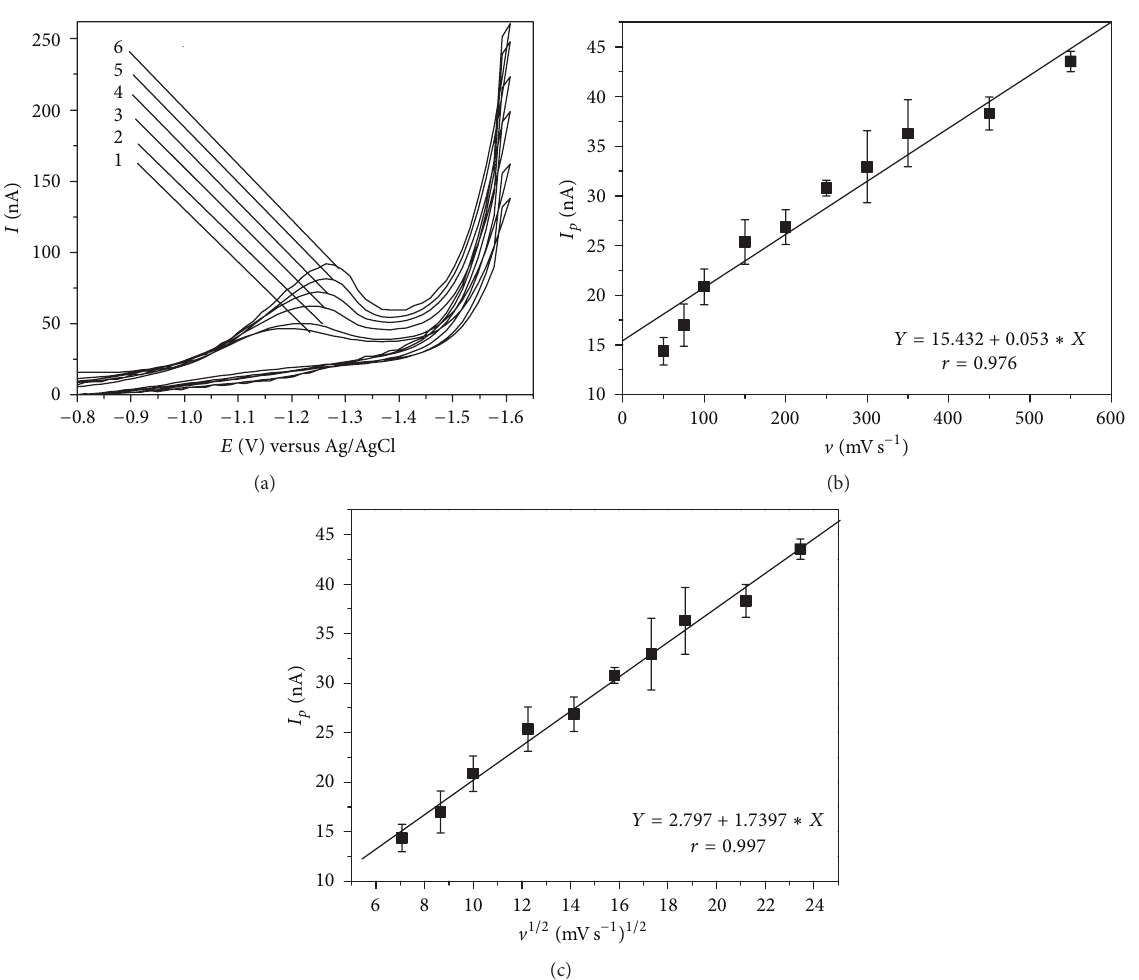
Figure 2: Study of the electrochemical process of EE2 (119.5 𝜇 gL −1 ) in Britton-Robinson buffer (pH 7.0) at HMDE by cyclic voltammetry. (a) Cyclic voltammograms with scan rates: (1) 50 mVs −1 ; (2) 100 mVs −1 ; (3) 200 mVs −1 ; (4) 300 mVs −1 ; (5) 450 mVs −1 ; (6) 550 mVs −1 . (b) Dependence of the peak current intensity as function of scan rate. (c) Dependence of the peak current intensity as function of square root of the scan